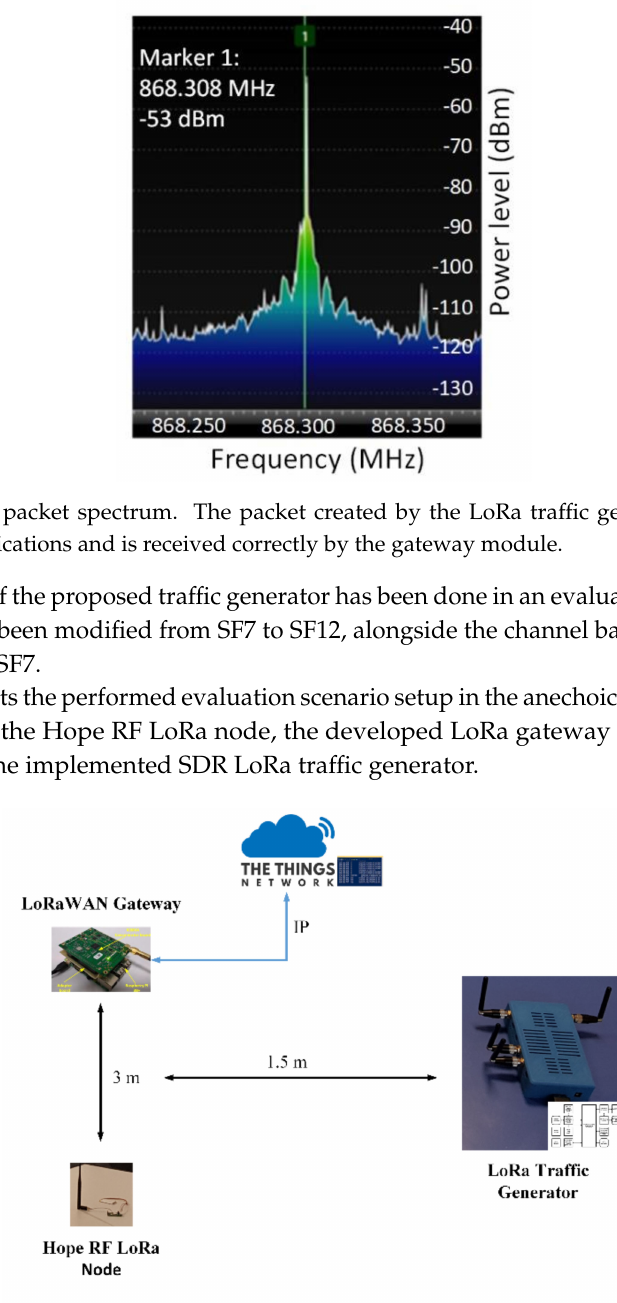
Figure 13. LoRa packet